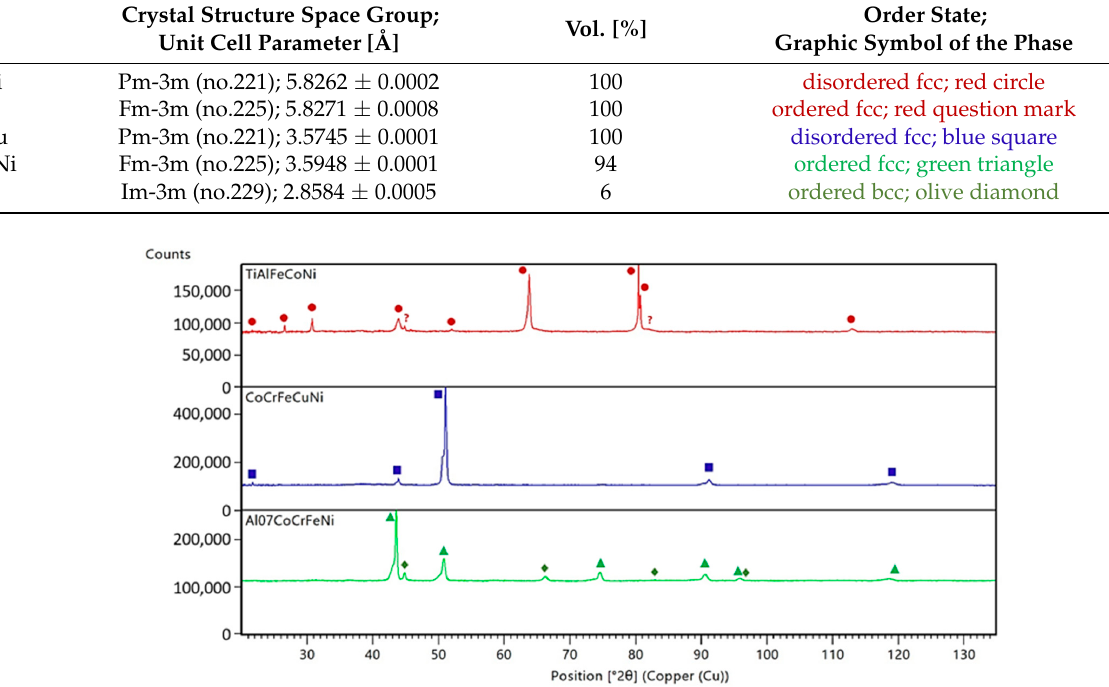
Figure 6. Room temperature X-ray diffraction patterns of TiAlFeCoNi—top red diagram, CoCrFeNiCu—middle blue diagram, and Al 0.7 CoCrFeNi—bottom green diagram. The symbols correspond to the different fcc phases (circles, squares, and triangles), while the bcc phase is represented by diamonds only.